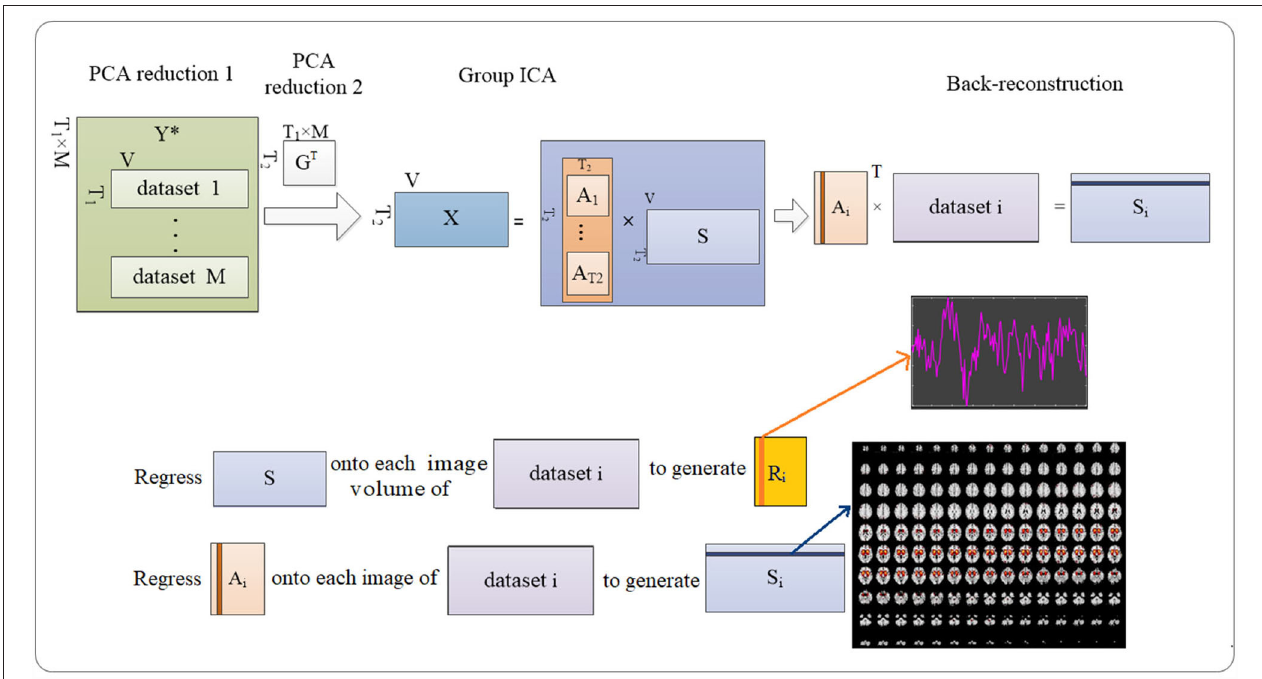
FIGURE 4 | Procedures to detecting the ICs. Group-level ICA decomposes resting-state data from the subjects into ICs (number = 100). Then back reconstruction estimates IC for each subject.